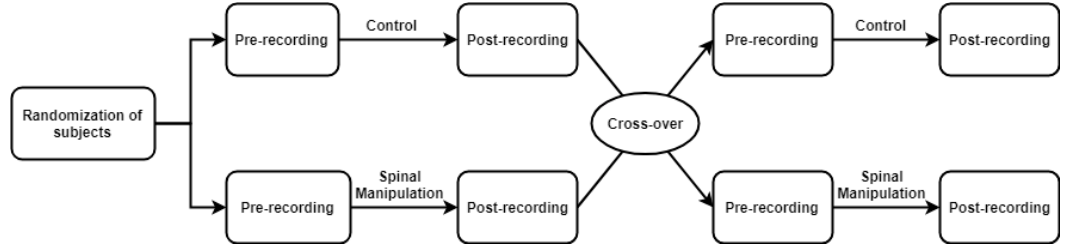
Figure 1. Illustration of the crossover study design and recording allocation.